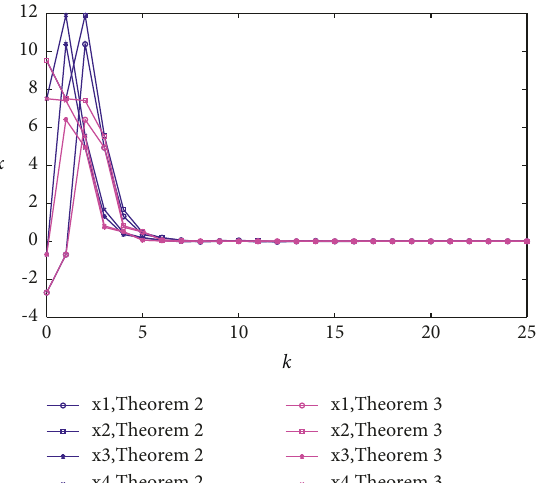
Figure 17: Control input signals.